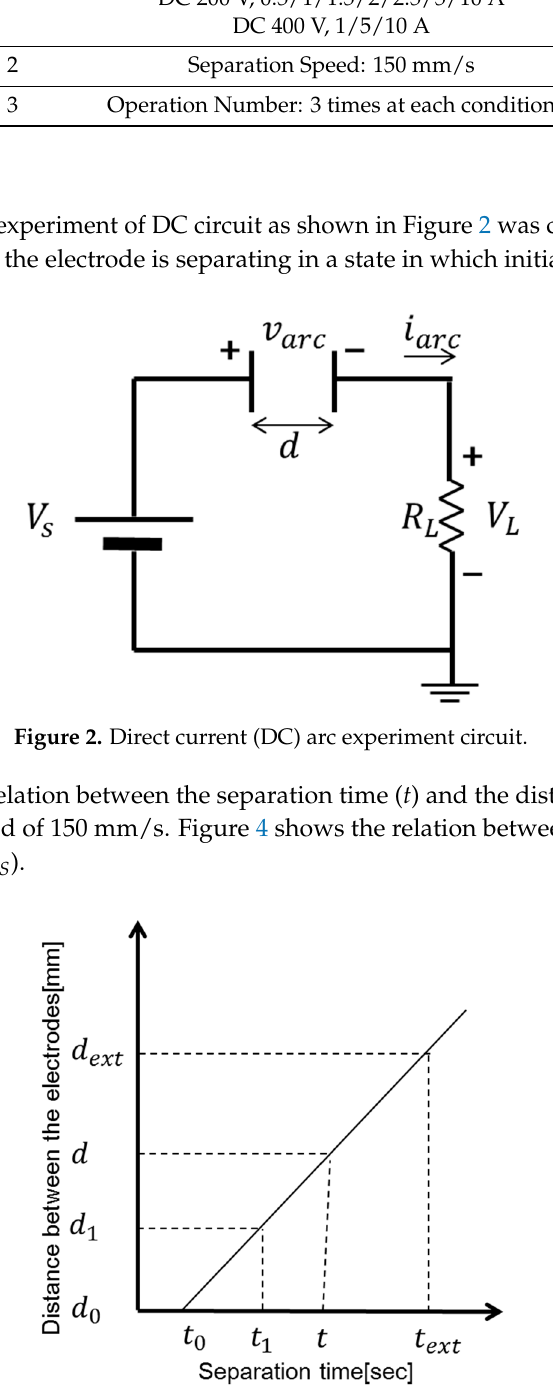
Figure 3. Distance between the electrode.